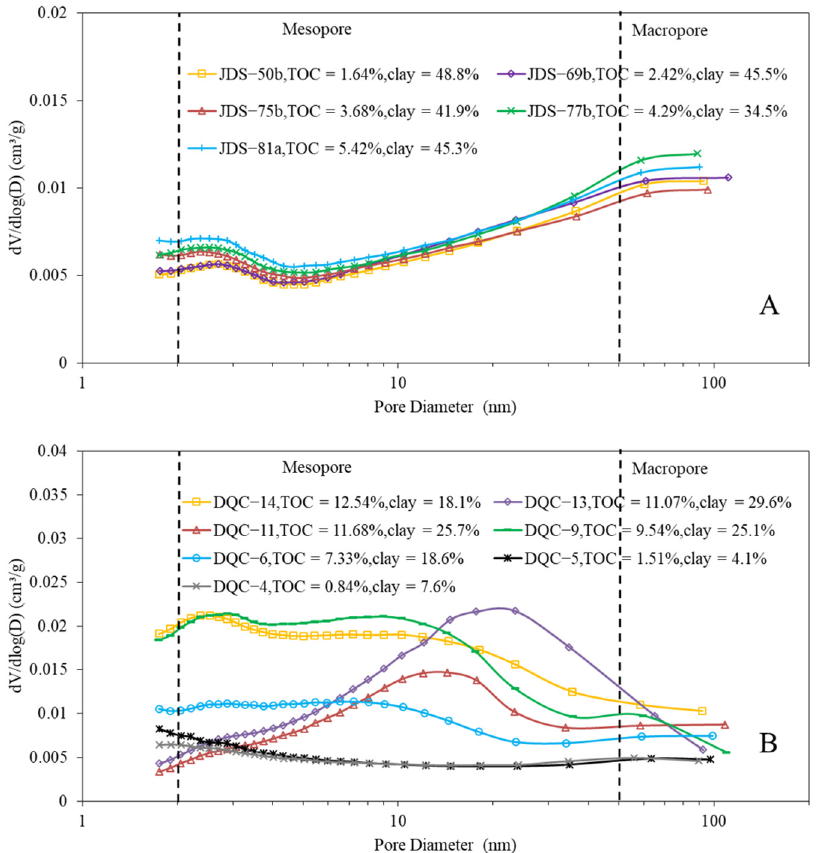
Figure 8. Pore volume distribution is determined via the Barrett-Joyner-Halenda method, assuming Harkins-Jura’s thickness equation model. ( A ) Niutitang shale samples from JDS-1 well. ( B ) Niutitang shale and chert samples (grey and black) from the Danquancun section. There are relatively few residual organic pores in the Niutitang shale underlying floor interval with high permeability in the Jindingshan section, but relatively more residual organic pores can be observed in the Niutitang shale underlying floor interval with low permeability in the Danquancun section. Nanopores are not developed in chert.